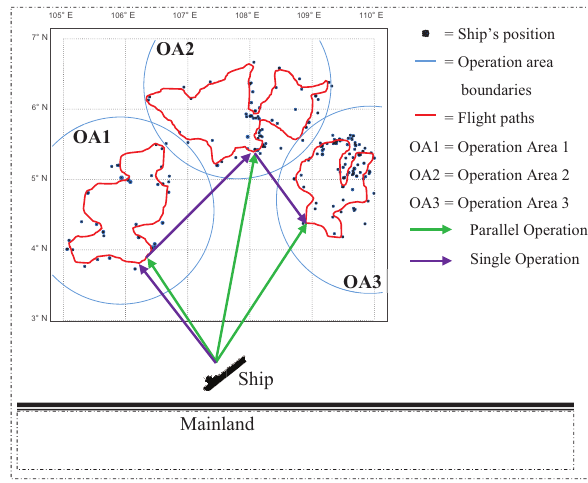
Figure 2. Illustration of the overall mission Table 1. General technique on